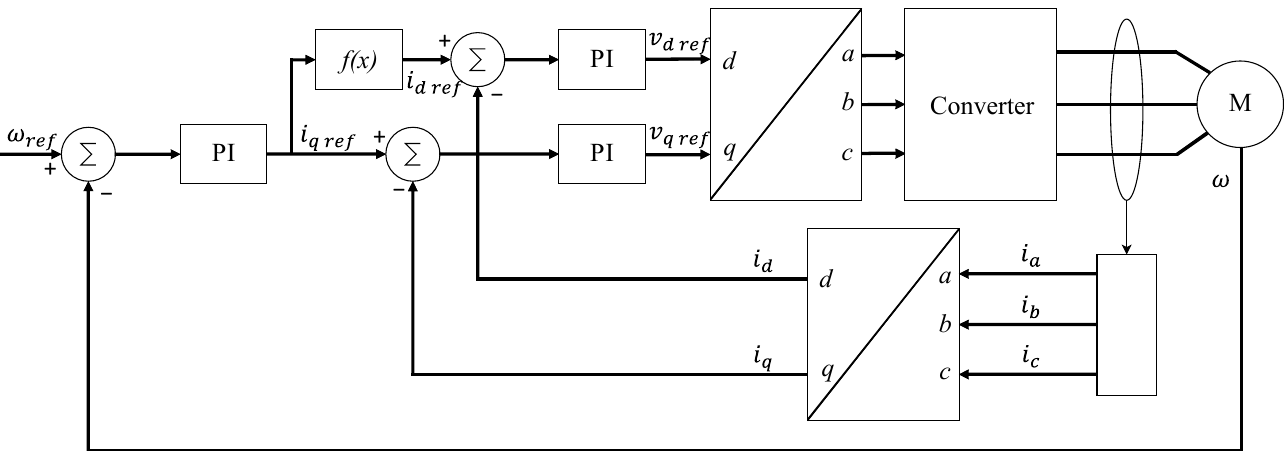
Figure 1. Control block diagram illustrating the maximum torque per ampere (MTPA) algorithm. The traction system that acts an interface between the ba tt eries and the SRPM ma- chine consists of an ac-dc and dc-dc converters sharing a dc-link, the ac-dc being a three- phase three-leg bidirectional converter with six insulated-gate bipolar transistors (IGBTs), and the dc-dc being a three-phase interleaved bidirectional buck-boost converter with six IGBTs, which means that both converters were similar in design, as can be seen in Figure